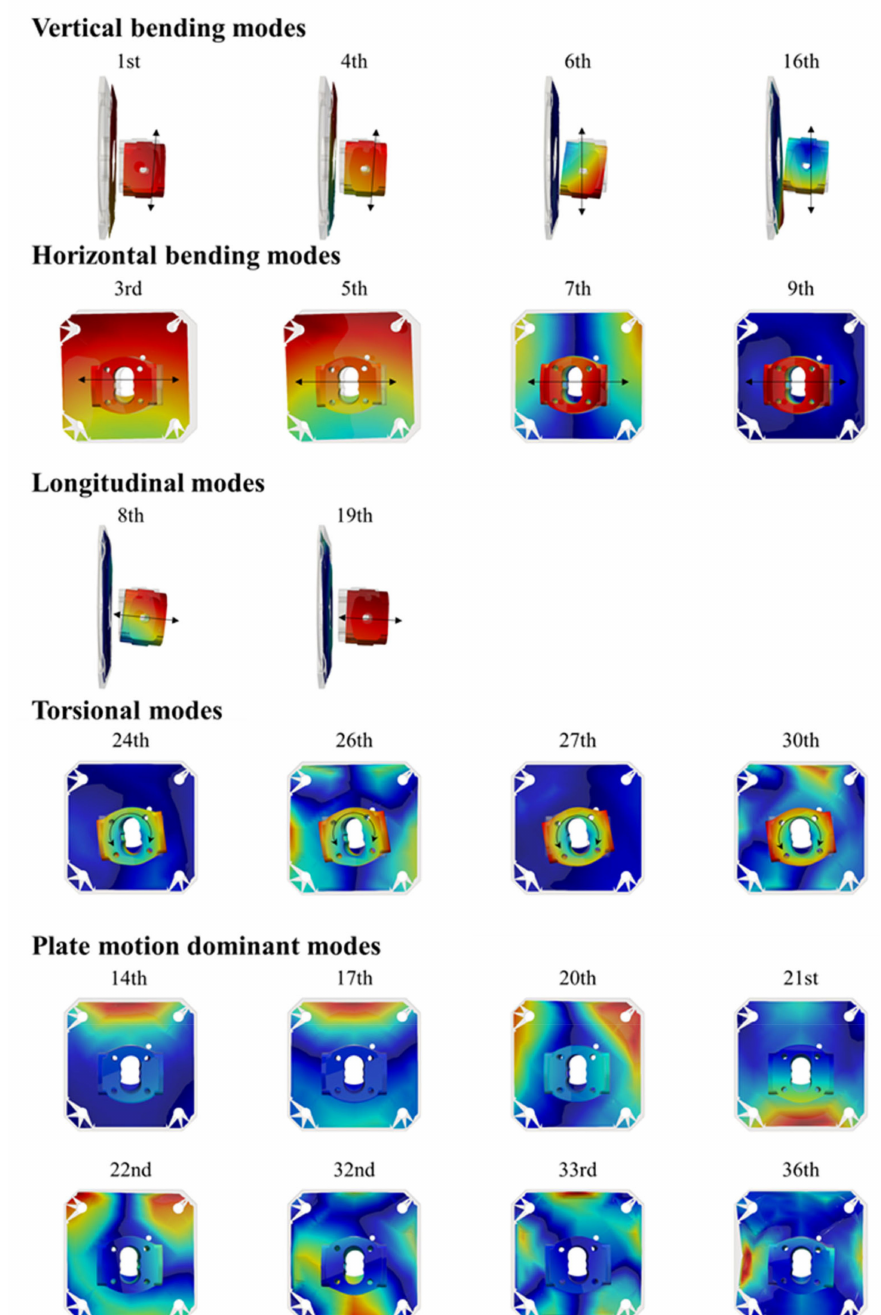
Figure 7. Experimental mode